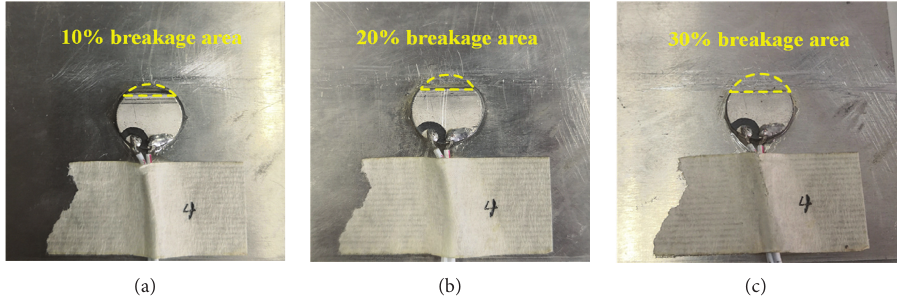
Figure 7: Breakage of 4# PZT. (a) 10% breakage; (b) 20% breakage; (c) 30%